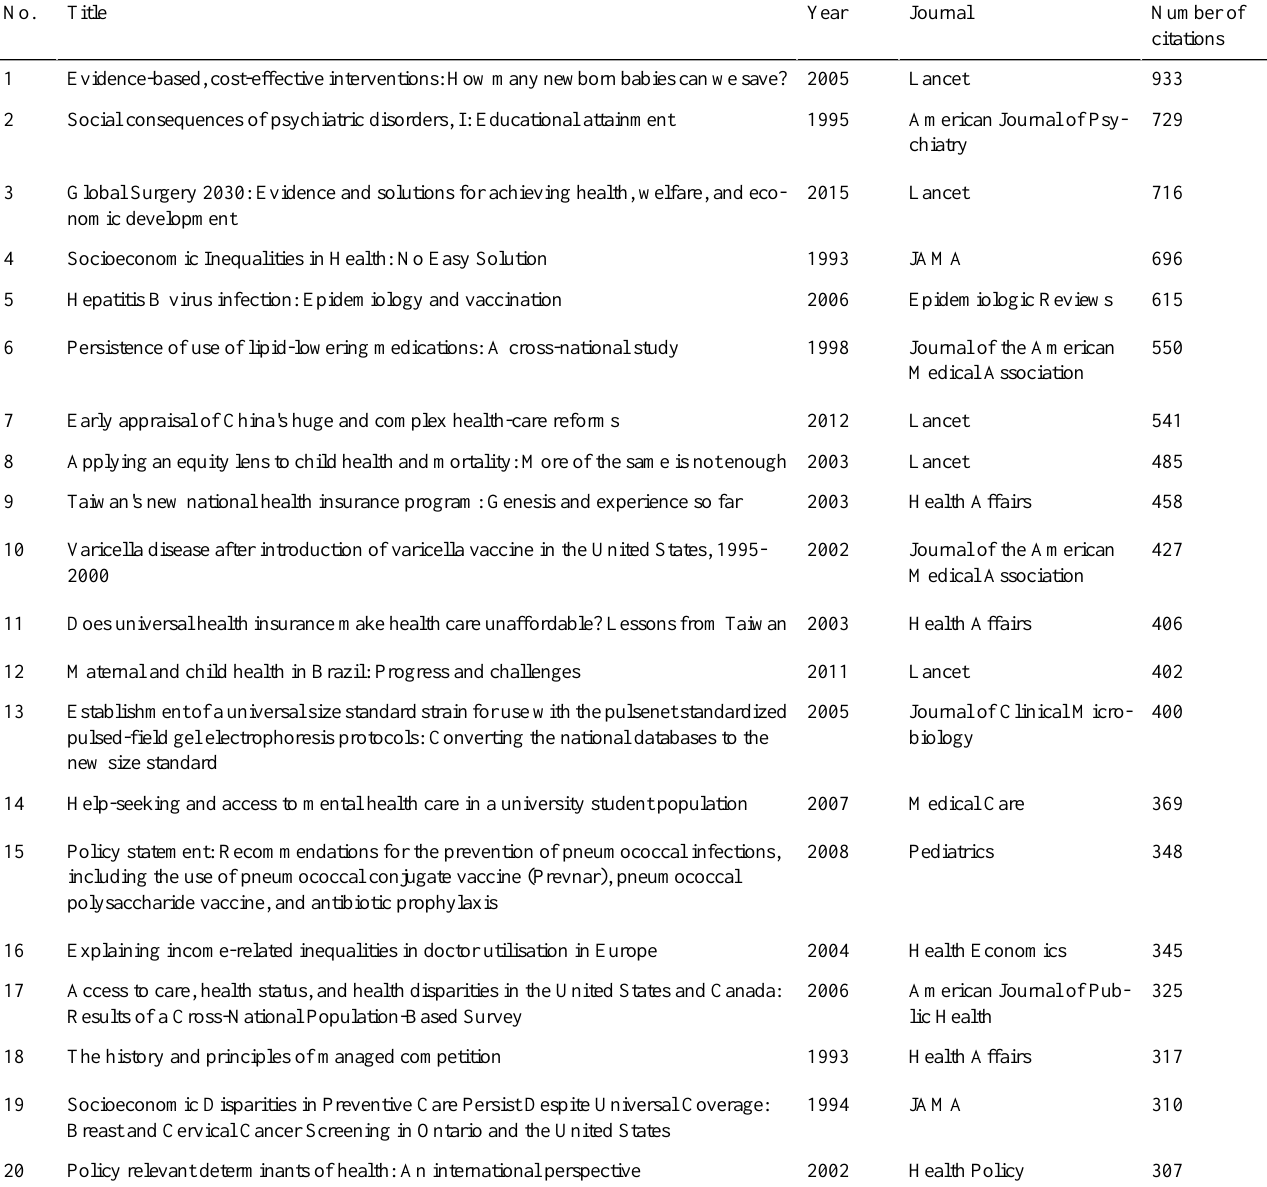
Table 7. Most cited papers related to universal health coverage.